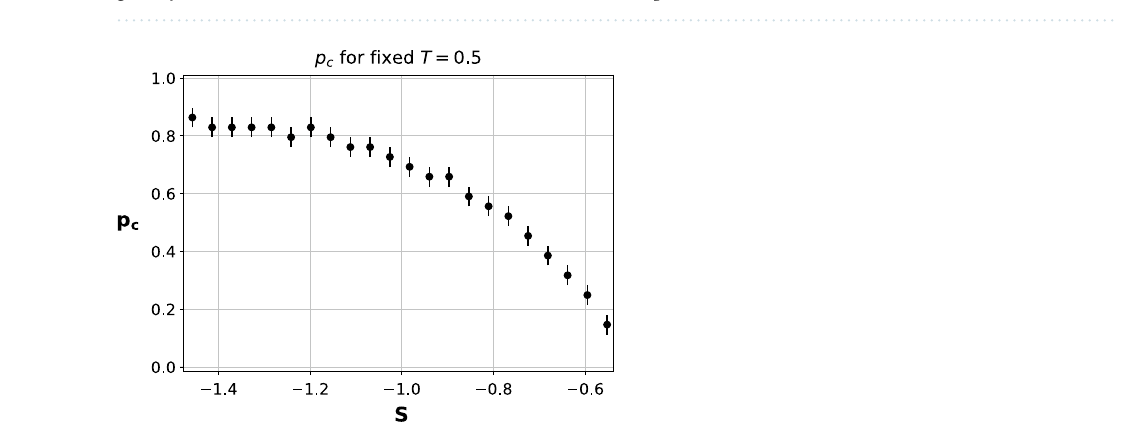
Figure 8. Value p c ( S ) for which we have the transition from the risk-dominant action to the payoff-dominant